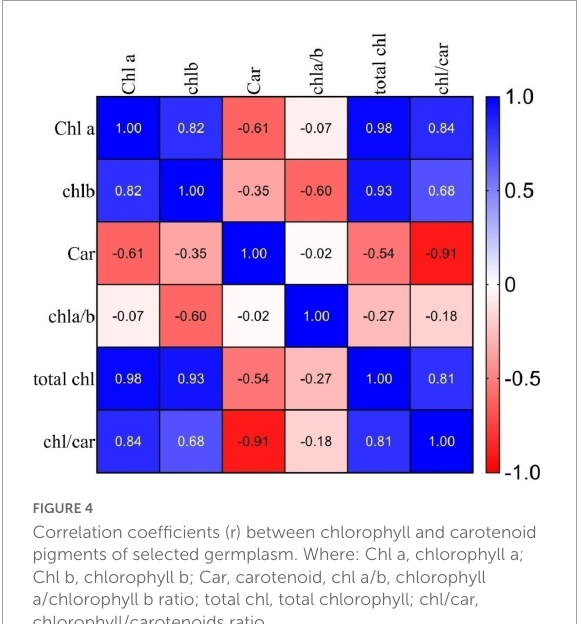
FIGURE4 Correlation coefficients (r) between chlorophyll and carotenoid pigments of selected germplasm. Where: Chl a, chlorophyll a; Chl b, chlorophyll b; Car, carotenoid, chl a/b, chlorophyll